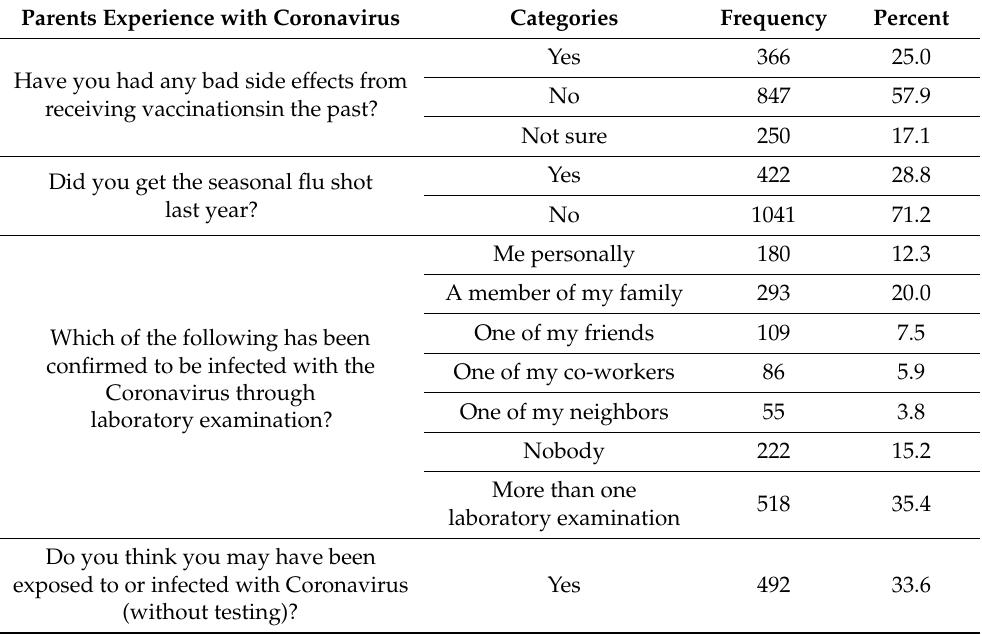
Table 3. Parents experience towards vaccinations, immunity, and the coronavirus (COVID-19)